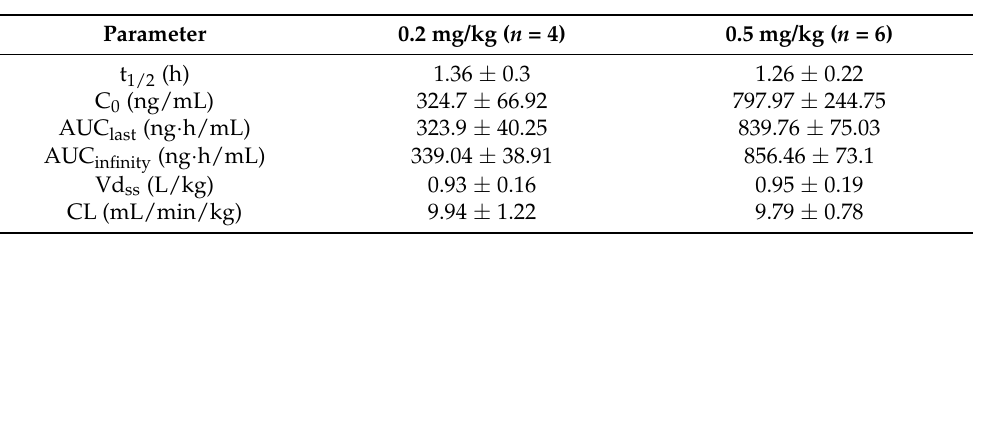
Table 4. Average non-compartmental toxicokinetic parameters of hexamethylenetetramine obtained after oral and percutaneous administration in rats. Parameter